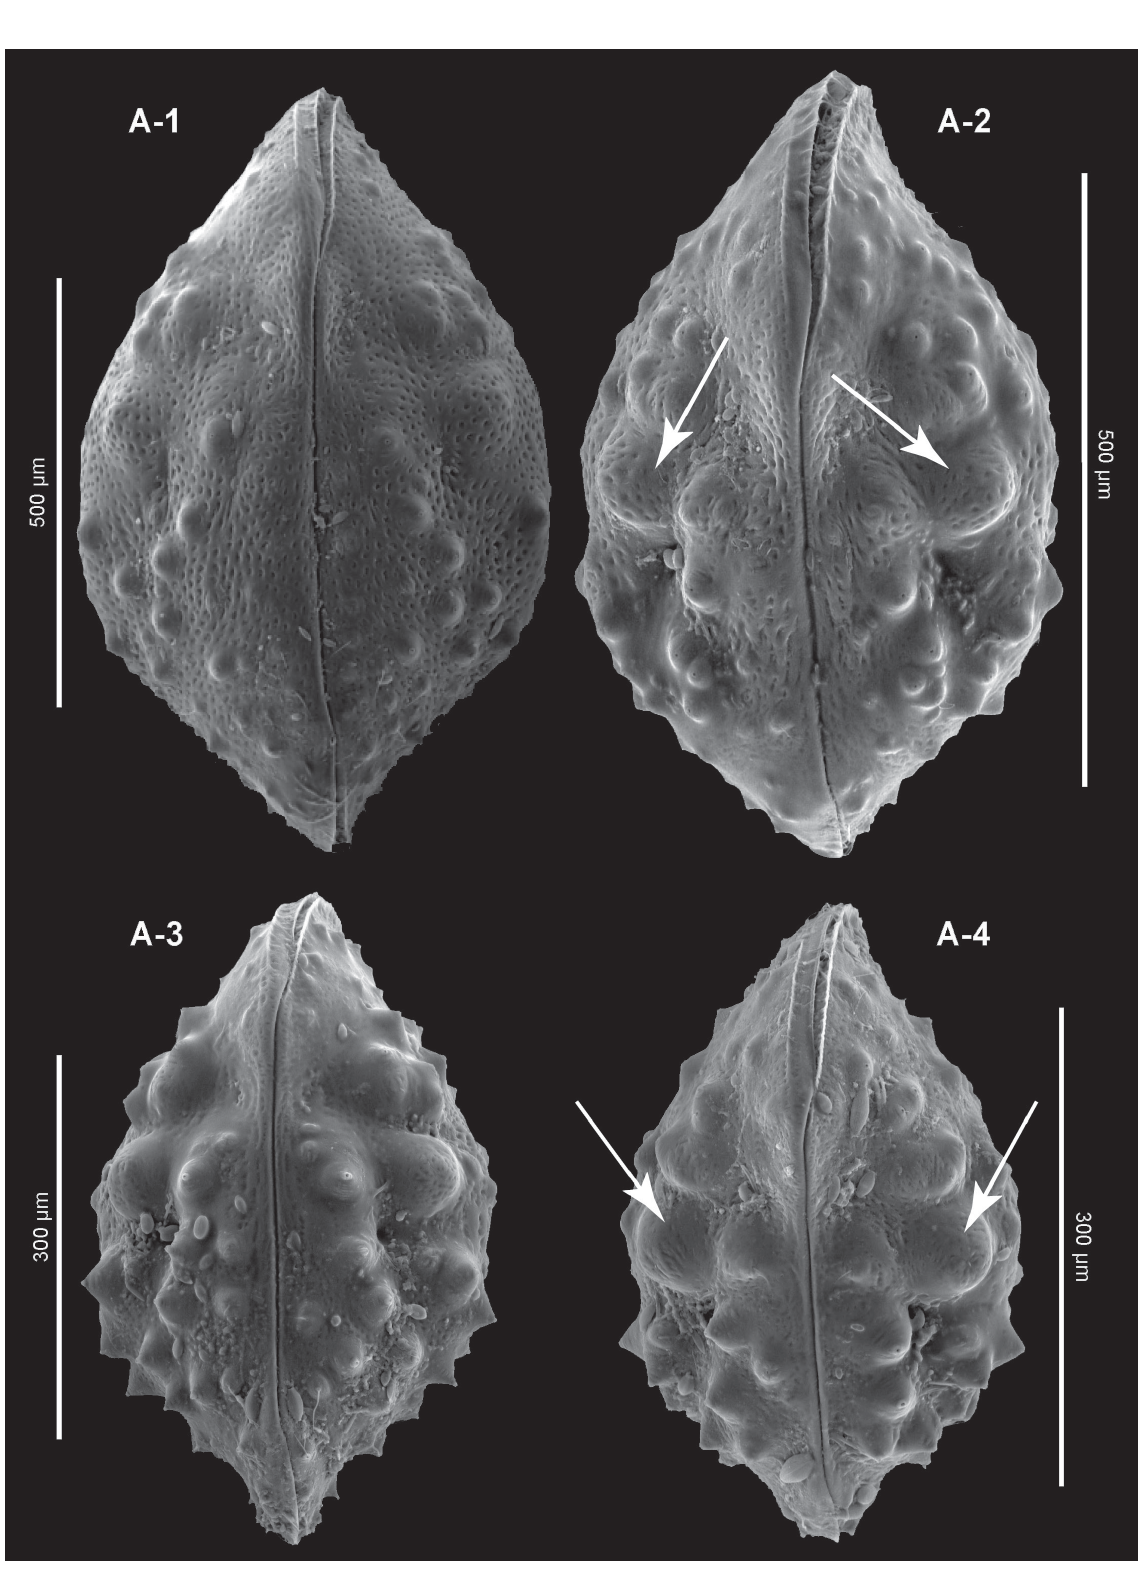
Fig. 3. External dorsal views of juvenile carapaces (A-1 to A-4) of Bennelongia cf . nimala nov. sp. from Muggon Lake. Domes are